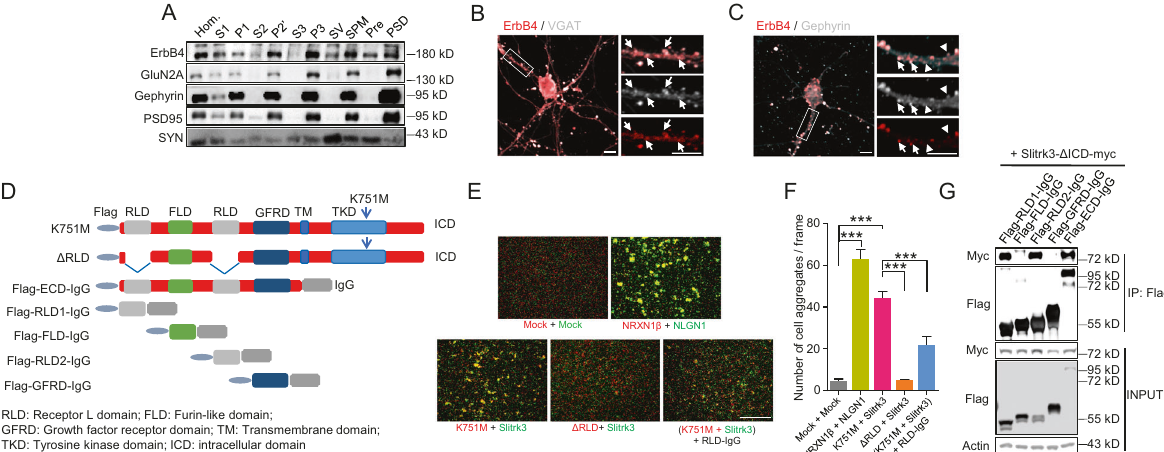
Fig. 4 ErbB4 interacts transcellularly with Slitrk3. A ErbB4 was distributed to the presynaptic and postsynaptic areas. Subcellular fractions of the WT brains were blotted with anti-ErbB4, anti-GluN2A (a postsynaptic glutamate receptor), anti-gephyrin (an inhibitory postsynaptic marker), anti-PSD95 (a PSD marker), and anti-synaptophysin (SYN, a presynaptic marker). Hom, homogenate; S1, supernatant; P1, pelleted nuclear fraction; P2, crude synaptosomal fraction; P2 ’ , washed crude synaptosomal fraction; S3, crude synaptic vesicle fraction; P3, lysed synaptosomal membrane fraction; SV, synaptic vesicle fraction; SPM, synaptosomal plasma membrane; Pre, presynaptic fraction; PSD, postsynaptic density. B , C Colocalization of ErbB4 with VGAT ( B ) or gephyrin ( C ). Primary hippocampal neurons at DIV10 were co-stained with ErbB4 and VGAT or gephyrin. Boxed areas were enlarged in the respective right images. Arrows indicate the co-localized ErbB4 with VGAT or gephyrin, and arrowheads indicate ErbB4 puncta alone. Scale bar, 20 μ m for lower magni fi cation images and 10 μ m for enlarged images of boxed areas. D Schematic illustration of constructs with different ErbB4 domain structures. E , F In trans ErbB4 – Slitrk3 interaction required the RLD of ErbB4. Representative images of cell aggregation assay ( E ). Scale bar, 1 mm. HEK392T cells co-transfected with DsRed and K751M, Δ RLD, NRXN1 β or Mock mixed with HEK392T cells co-transfected with EGFP and Slitrk3, NLGN1 or Mock. In K751M + Slitrk3 + RLD-IgG group, recombinant RLD-IgG protein was added to the mixture of K751M cells and Slitrk3 cells. Quantitative analysis of cell aggregates in E ( F ). Data were from three independent experiments and shown as mean ± SEM. *** p < 0.001. One-way ANOVA. G ErbB4 interacted with Slitrk3 through RLD domain. HEK293T cells were co-transfected with myc-tagged Slitr3- Δ ICD plus Flag-tagged different ECD domains of ErbB4 and subjected to co-IP with